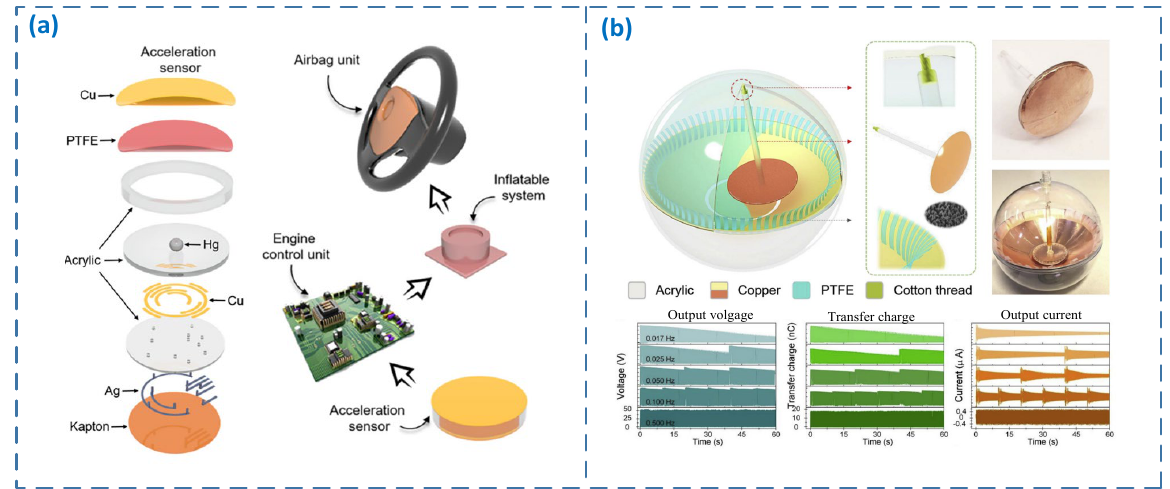
Figure 1. Application of Triboelectric Nanogenerator. ( a ) Triboelectric nanogenerator used to measure acceleration [22]; ( b ) Triboelectric nanogenerators for energy harvesting [37].